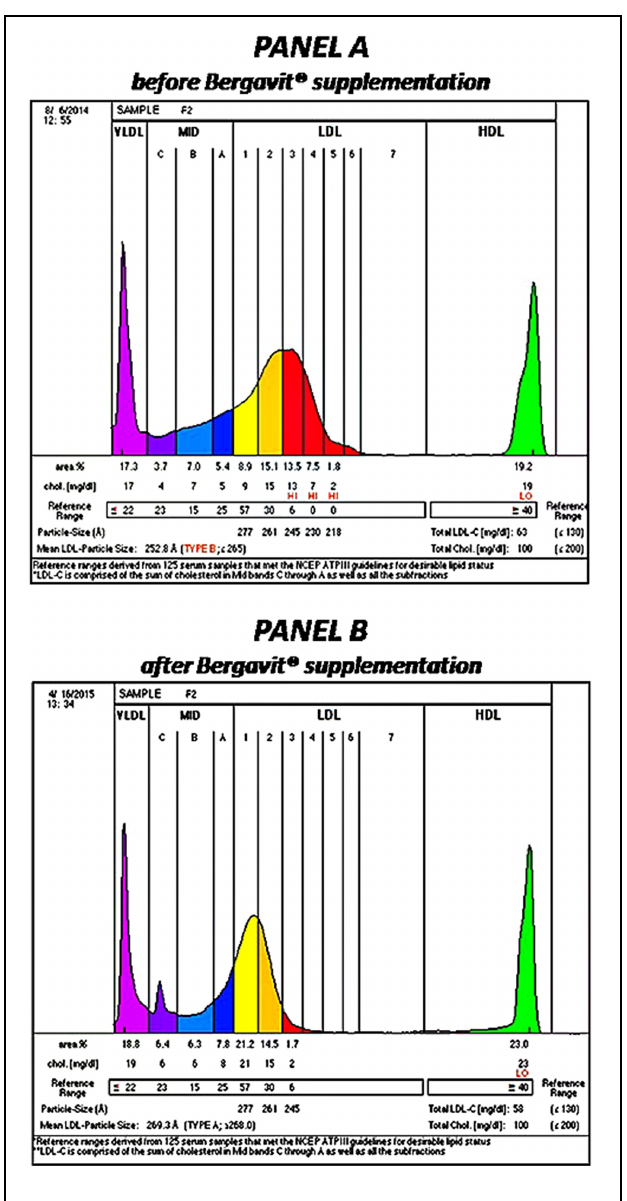
FIGURE 3 | Lipoprotein profile of a rapresentative subject before (PANEL A) and after (PANEL B) 6 months of Bergavit R (cid:2) (150 mg of flavonoids, with 16% of neoeriocitrin, 47% of neohesperidin, and 37% of naringin, daily) supplementation. Lipoprint color graphs are generated by lipoprint sytem using Lipoware Clinical Analysis